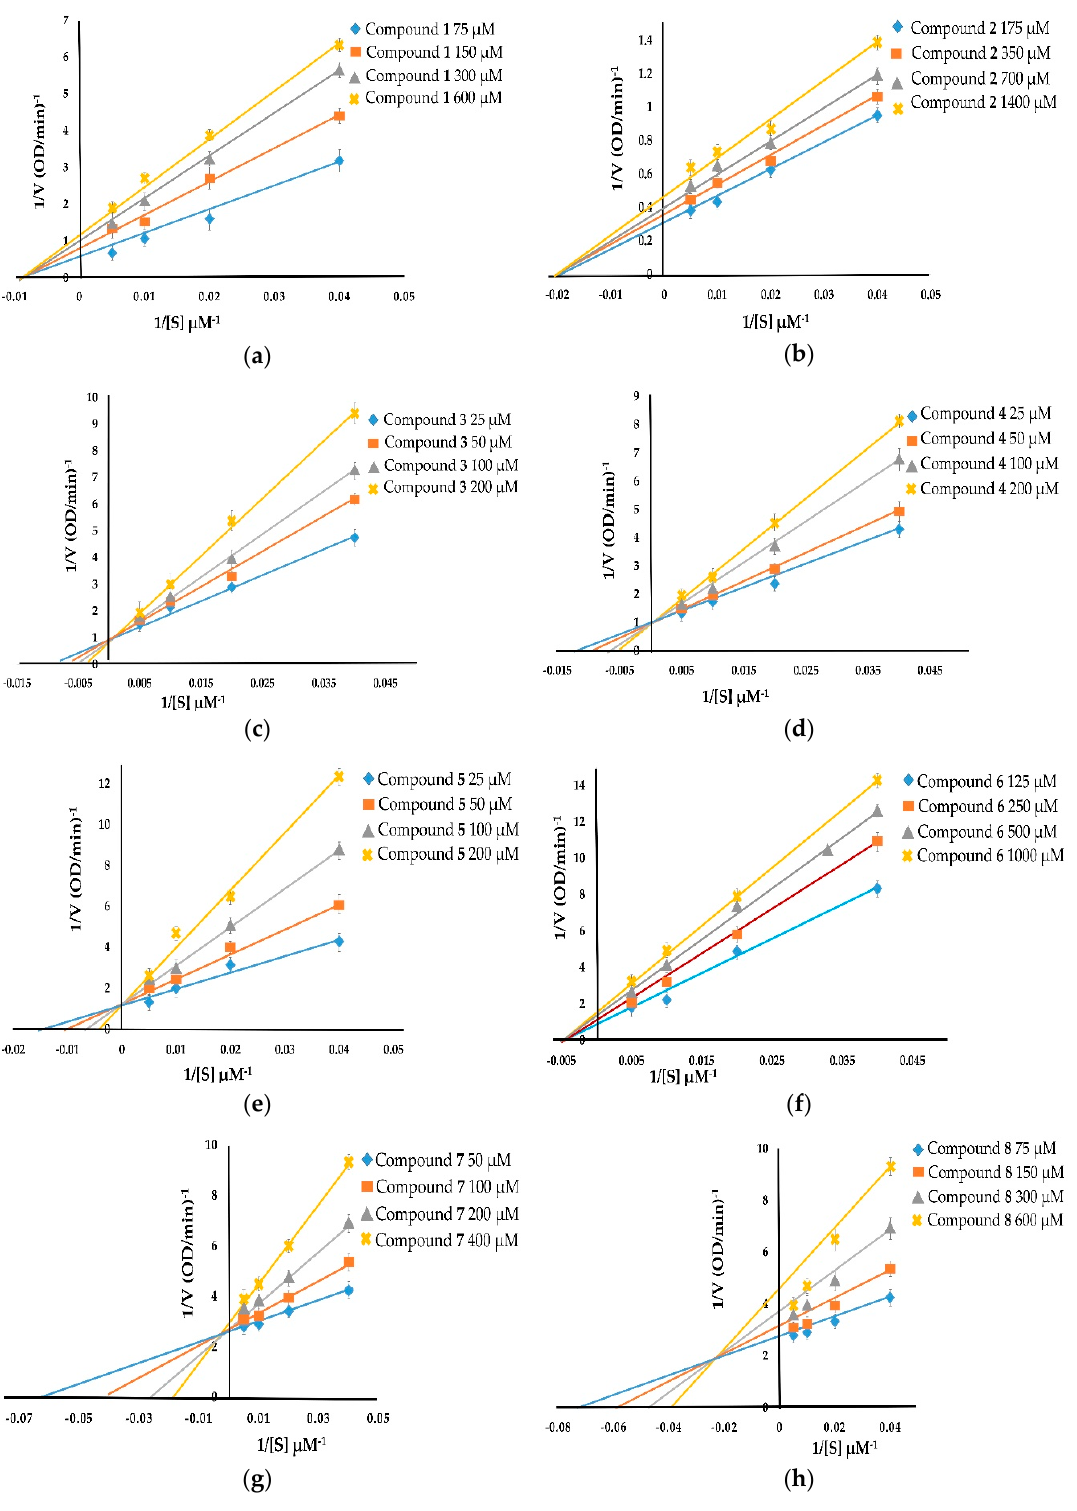
Figure 2. Lineweaver–Burk plots of compounds 1 – 8 showing monophenolase inhibitory activity: ( a ) taraxerol methyl ether ( 1 ); ( b ) spinasterol ( 2 ); ( c ) 6-hydroxyflavanone ( 3 ); ( d ) ( + )-dihydrokaempferol ( 4 ); ( e ) 3,4-dihydroxybenzoic acid ( 5 ); ( f ) taraxerol ( 6 ); ( g ) taraxerone ( 7 ); and ( h ) lupeol acetate ( 8 ). With respect to diphenolase inhibitory activity (Figure 3), taraxerol methyl ether ( 1 ) and spinasterol ( 2 ) were noncompetitive inhibitors. Their Lineweaver–Burk plots show a family of lines with different slopes in which the V max values were altered, whereas the K m value persisted with the